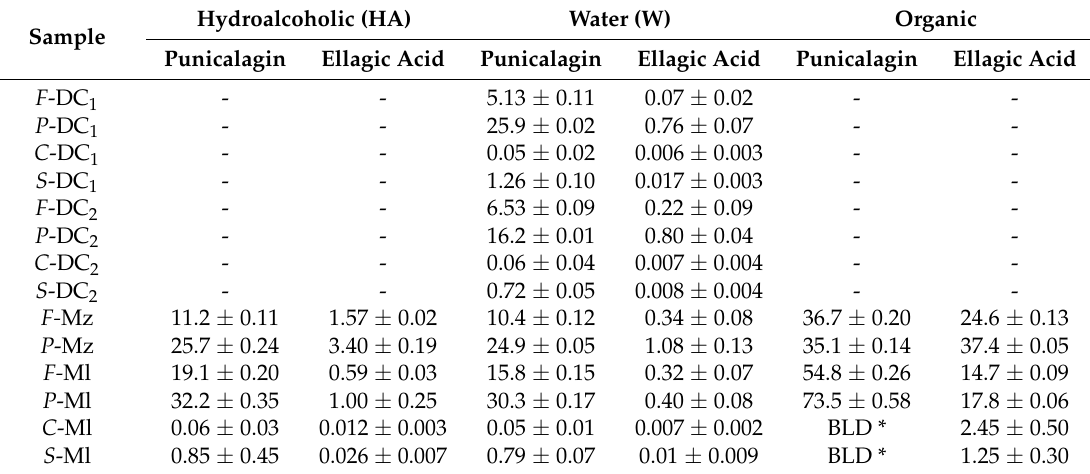
Figure 1. Flow chart and chromatographic profile of the phenolic compounds of selected samples. Table 1. Quali–quantitative analyses of the two studied metabolites in the differently obtained pomegranate